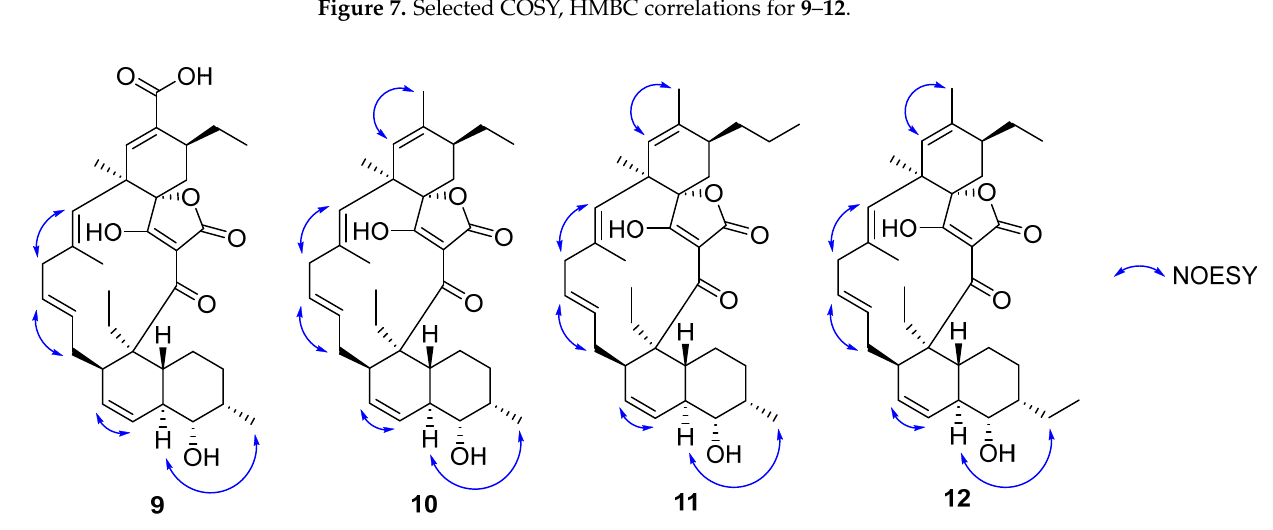
Figure 8. Selected NOESY correlations for 9 - 12 .